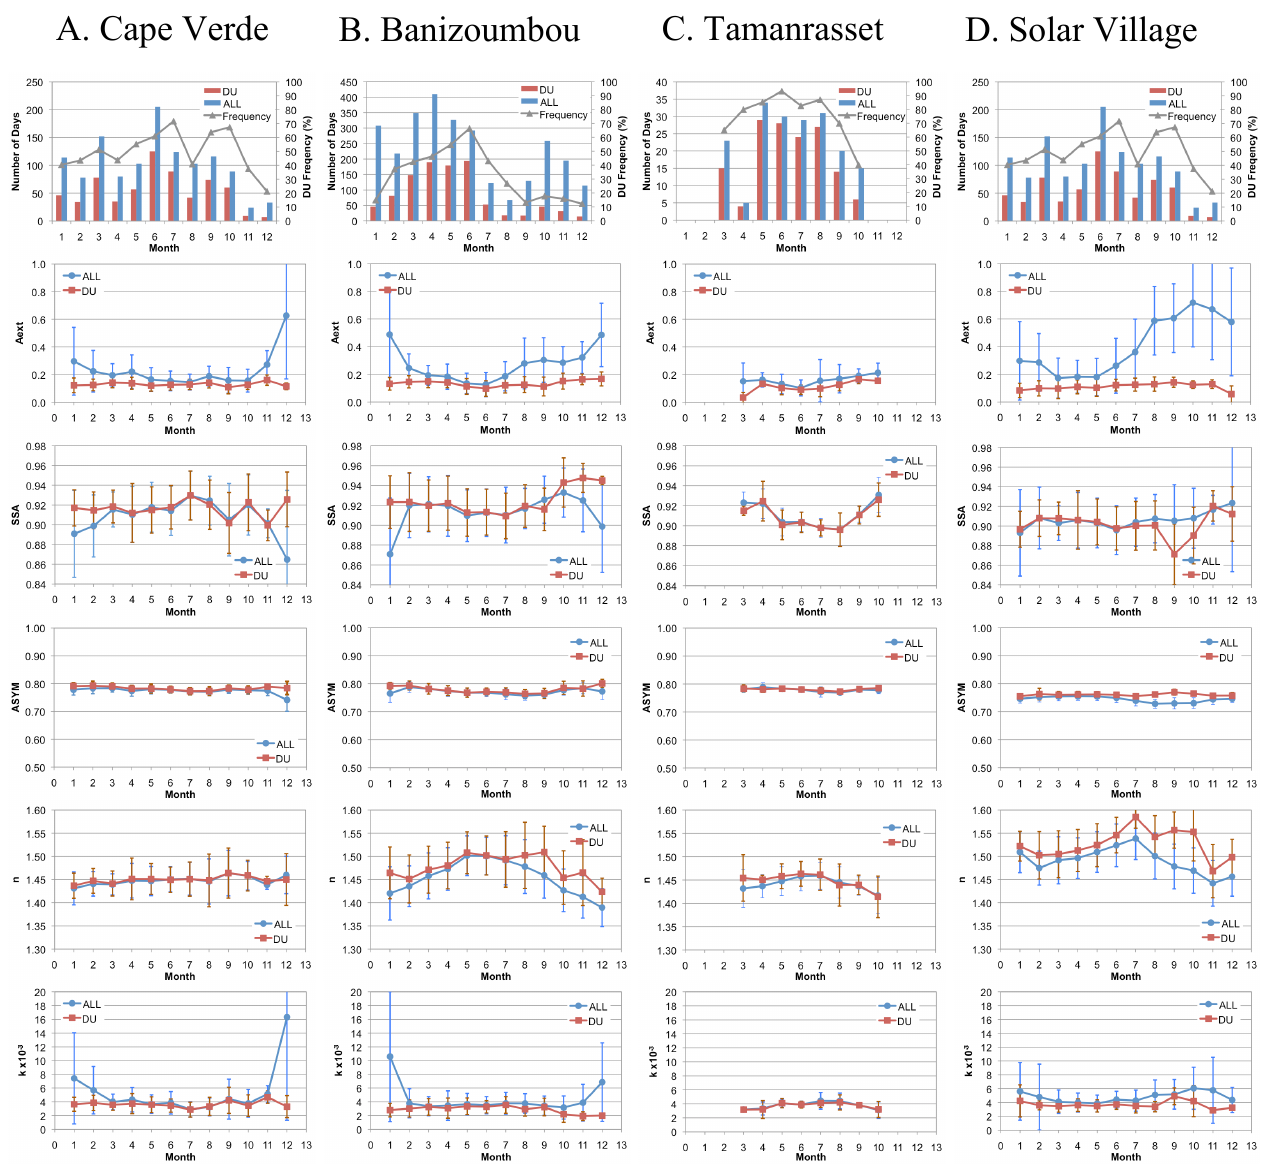
Fig. 2. Sampling frequency (first row) and DU optical properties of ˚A ext (440–870nm) (second row), SSA (third row), ASYM (fourth row), and real and imaginary part of refractive indices (fifth and sixth row) at 440 nm at four selected sites (column